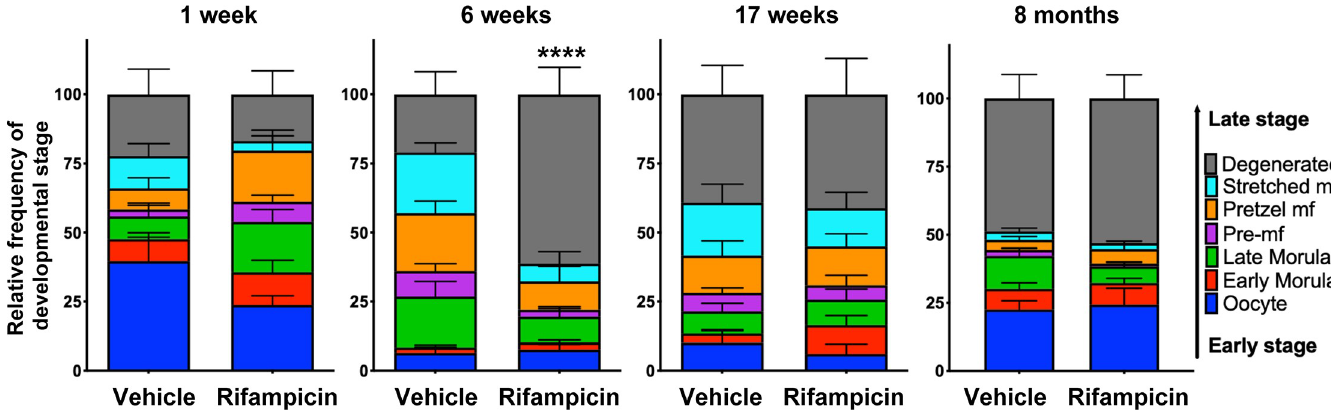
Fig 3. Rifampicin treatment leads to impaired embryogenesis by the 6-week timepoint but normal developmental stages return by 17 weeks. Embryonic stages found within the ovaries and uteri from female worms from the vehicle and treated groups were counted 1 week, 6 weeks, 17 weeks and 8 months post-first dose. There was a significant decrease in the frequency of healthy embryos across all developmental stages of embryogenesis at the 6-week timepoint ( ���� P < 0.0001). Percentages of degenerated embryos (gray) were also determined for each timepoint. Data are presented as mean ± SEM. n = 6–9 female worms from n = 2–9 jirds per treatment group per